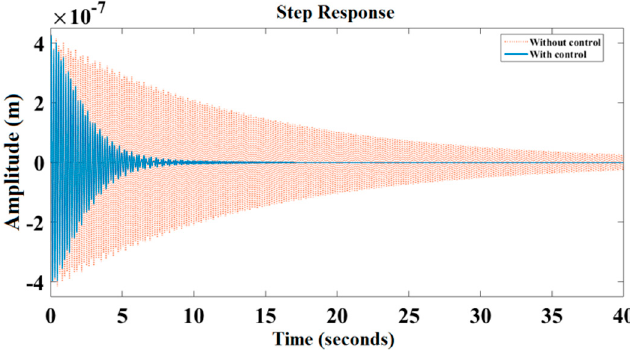
Figure 13. Step response of the beam (Sensors in FE3, Q = 10 10 , R = 1, Gc = 100).